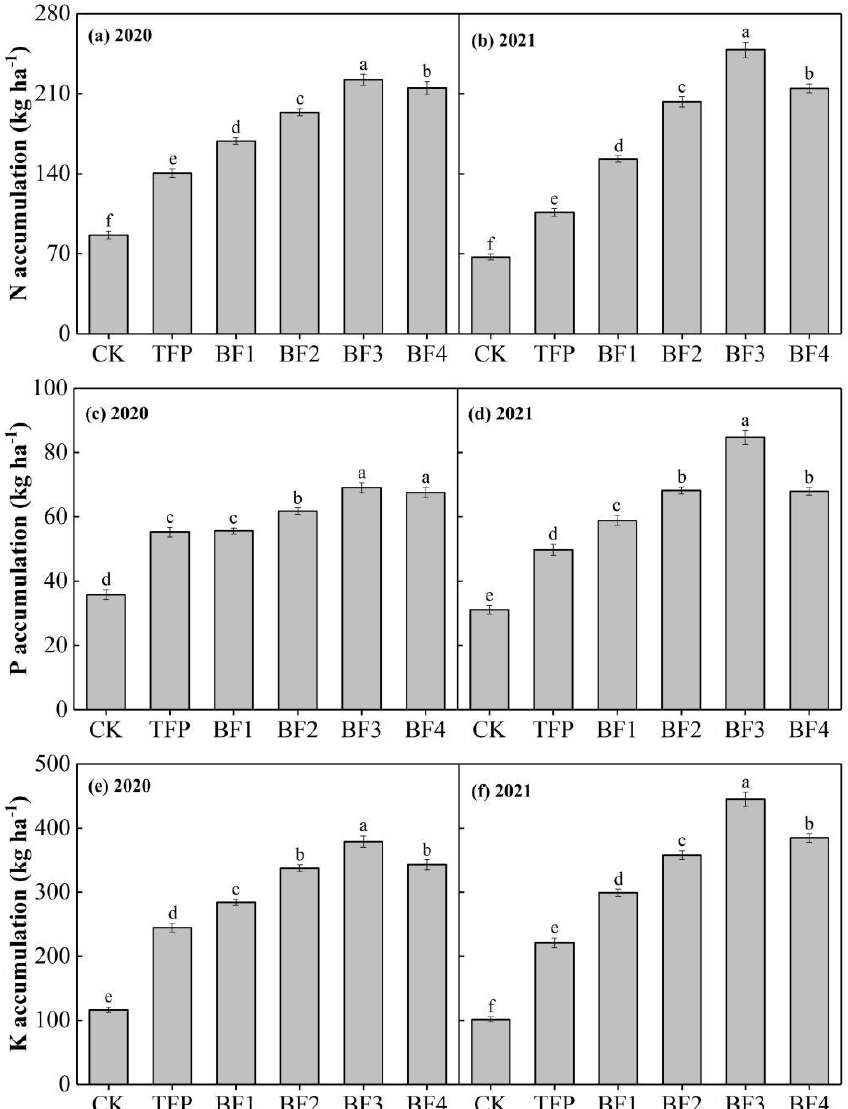
Figure 3. Effects of BF on the N, P and K accumulation in 2020 ( a , c , e ) and 2021 ( b , d , f ). CK—no fertilizer; TFP—traditional fertilization practice; BF1—1875 kg ha − 1 of biochar-based fertilizer (BF); BF2—2250 kg ha − 1 of BF; BF3—2625 kg ha − 1 of BF; BF4—3000 kg ha − 1 of BF. Different lowercase letters denote significant differences among treatment means at the α = 0.05 level using